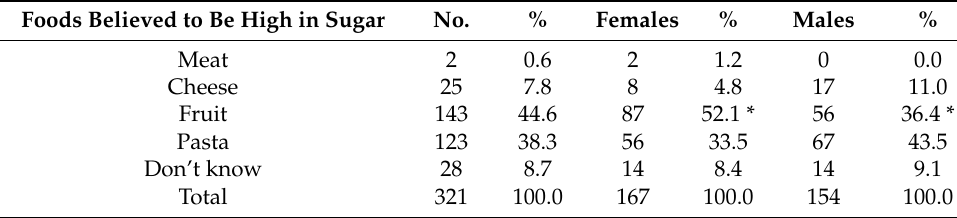
Table 5. Knowledge, by gender, of foods based on sugar content.